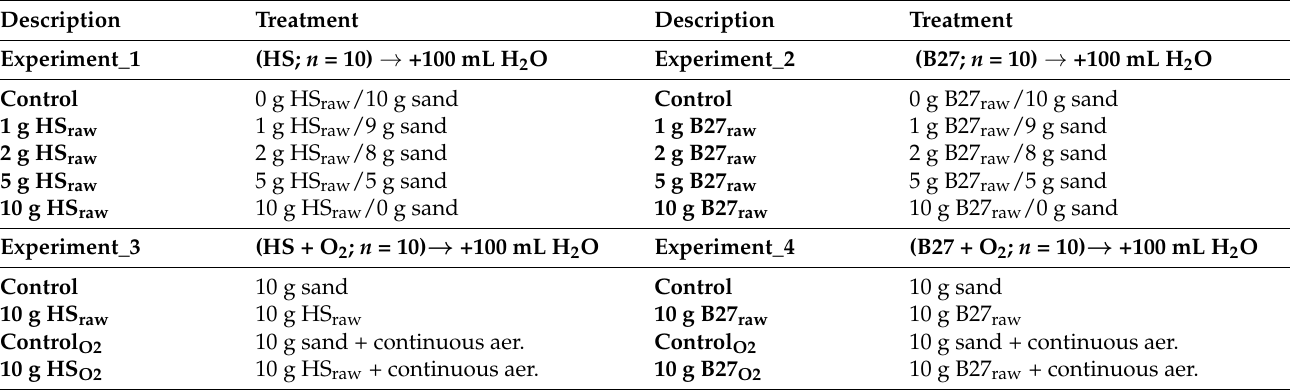
Table 1. Overview of all treatments used in experiments. Experiment_1: HS raw : raw, unfractionated sediment from the Halensee (HS) settling pond, dispersed in water. Experiment_2: B27 raw : raw sediment from the B27 settling pond (collected 28 April 2020), dispersed in water. Experiments_3 and 4 : 10 g HS O2 /10 g B27 O2 : the aerated, dispersed sediment from the HS/B27 settling pond (B27: each glass for the whole duration of the experiment. The vacuum flask setup ( NP ) is not included here because it was only possible to run a single replicate with each experiment ( n = 1). All: n refers to the number of glasses (replicates) for each treatment. Each glass contained five larvae. The total number of larvae per treatment is noted under the respective figures. (H 2 O/water: filtered water;